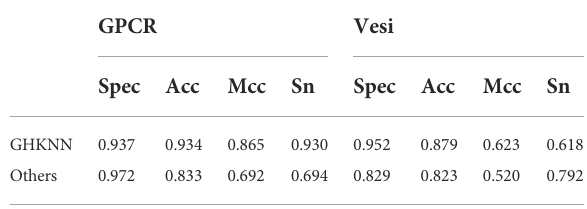
TABLE 6 Classi fi cation results using this experimental model on the GPCR and vesi datasets and the comparison with the previous experimental